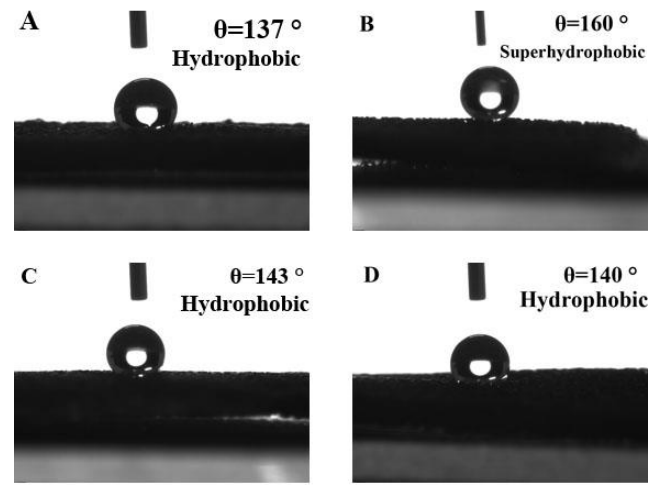
Figure 8. Static contact angle at different conditions: ( A ) solution concentration: 20 mmol/L, reaction temperature: 95 °C, reaction time: 4 h; ( B ) solution concentration: 40 mmol/L, reaction temperature: 95 °C, reaction time: 4 h; ( C ) solution concentration: 40 mmol/L, reaction temperature: 75 °C, reaction time: 4 h; and ( D ) solution concentration: 40 mmol/L, reaction temperature: 115 °C, reaction time: 4 h.